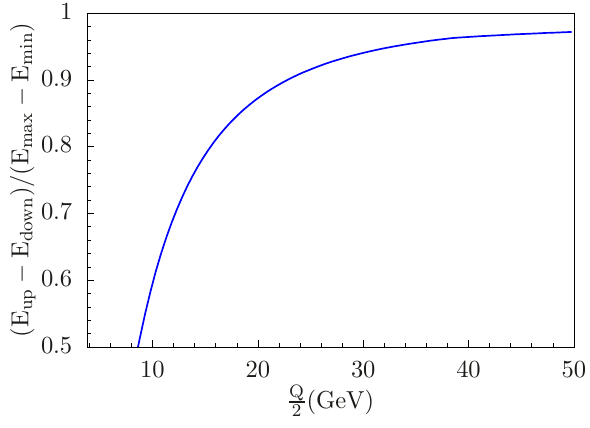
Figure 7 . The ratio, ( E up that describes NRQCD result within 5